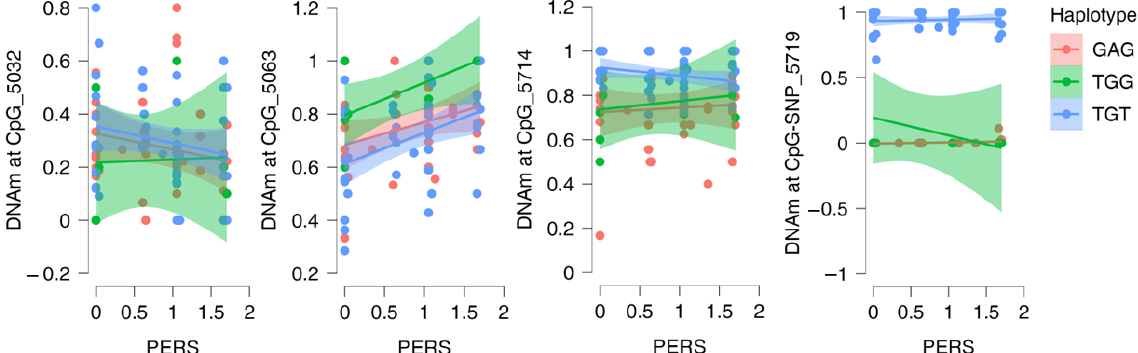
Figure 2. Relations of DNA methylation (DNAm) at variably methylated sites with local haplotypes (rs743575-rs4919687-rs3781287) and polyenviromic risk scores (PERS). CpG names contain last digits of their coordinates on chromosome 10, hg 19. For each haplotype, a regression line with 95% CI (shaded areas of the same color) are shown.